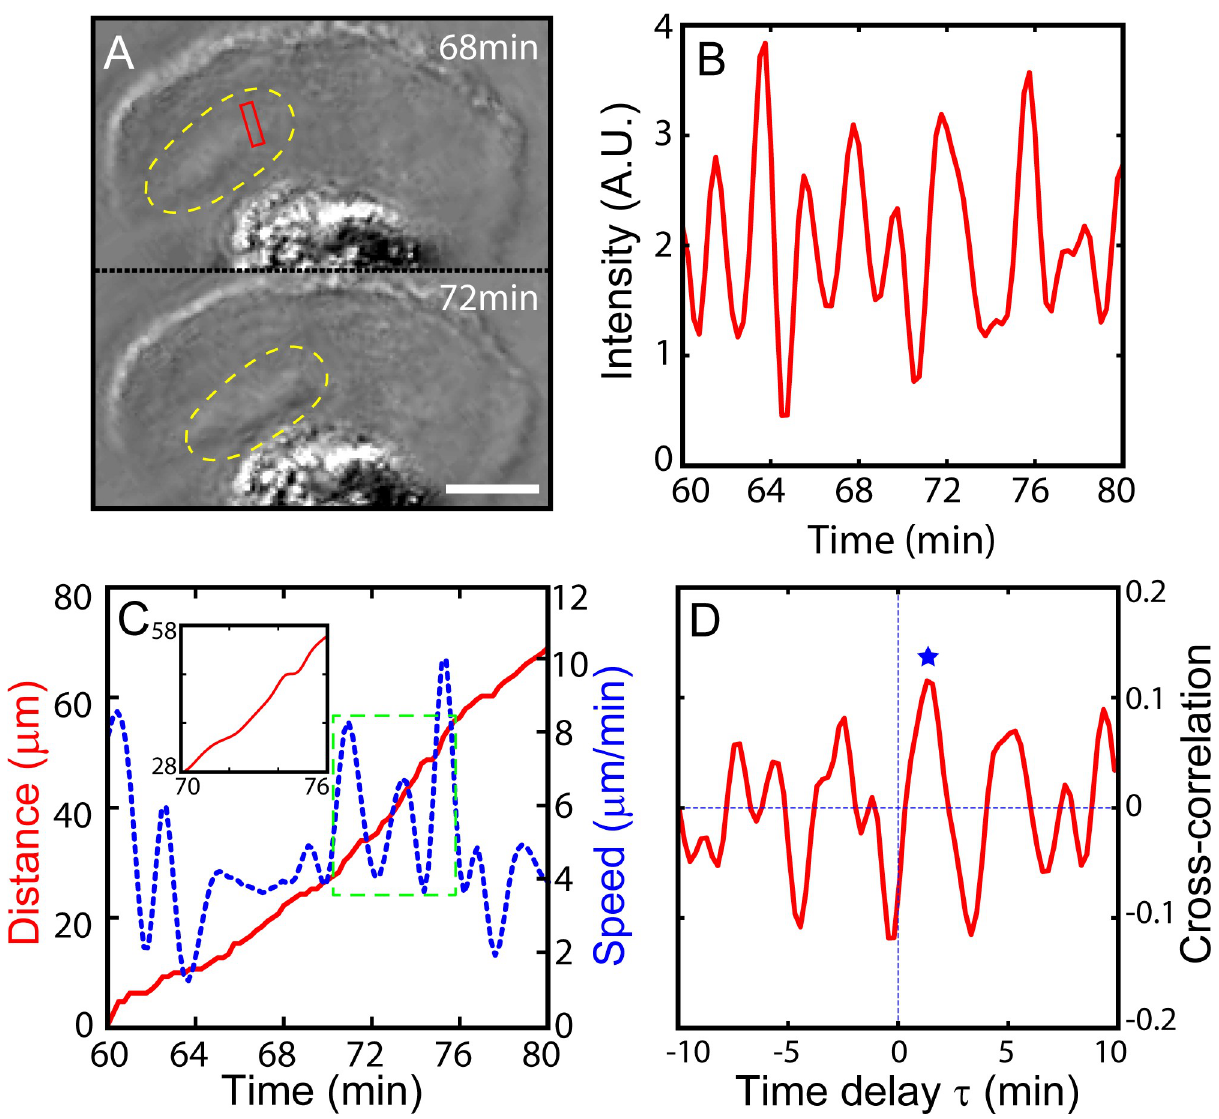
Fig 3. Correlation between periodic dorsal actin waves and the pulsatile movement of crawling MG cell body. A) PCM snapshot images showing a dorsal actin wave t = 68 and t = 72 minutes (dorsal actin wave is marked by yellow dotted line, see Visualization 4). B) The oscillatory average intensity (of the pixels inside the red box) time series indicating the periodic passage of dorsal actin waves travelling from the front to the cell body. C) Plots of the distance (red line) travelled by the crawling MG and its speed (blue dotted line). The inset is simply a close-up view of the distance inside the box bounded by the green dotted line. D) Cross-correlation function Cτ of the intensity fluctuation of dorsal actin wave and moving speed of crawling cell body. The blue star marks the first positive peak. Scale bar of A) is 10 μ m. Time series in B) and C) are based on a sequence of time-lapse images acquired at a time interval of 15